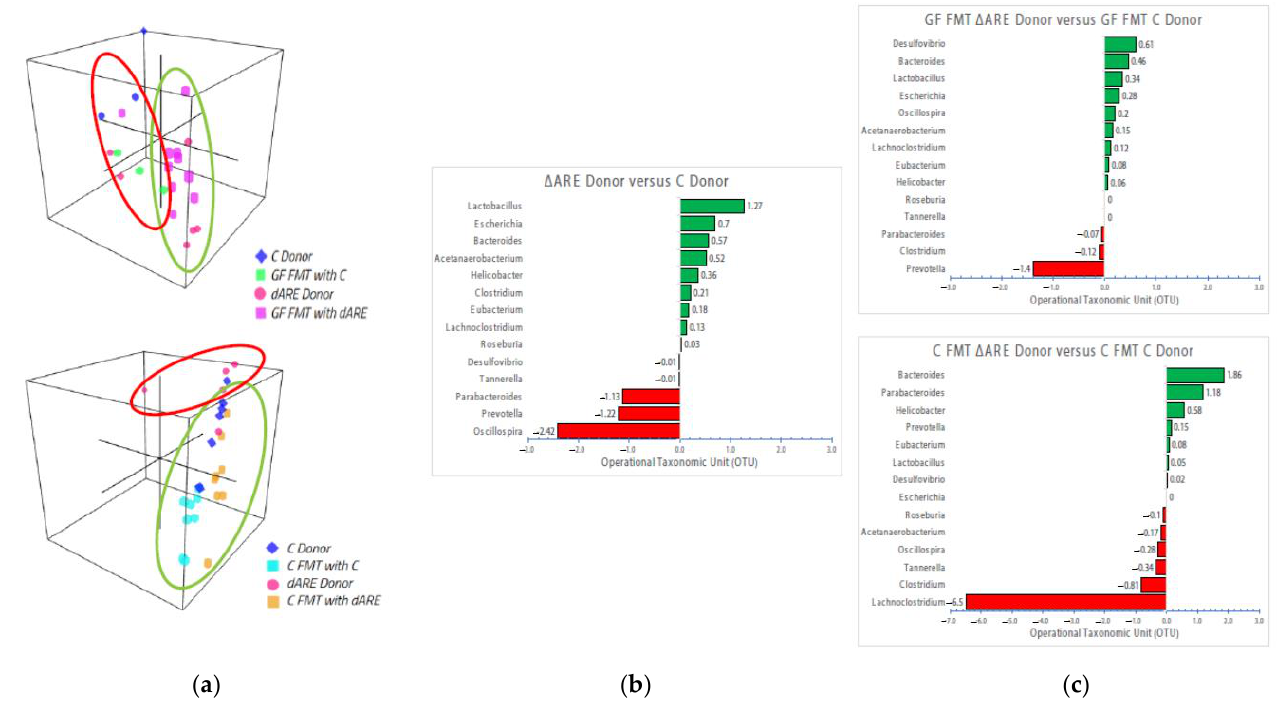
Figure 6. 3D visualization of genus communities in FMT colonies and bidirectional bar chart of the 14 genera identified in the disease transmission. Taxonomy panel at the Genus level. Panel ( a ) 3D representation of clustering at the genus level. Top: GF mice ( n = 13) 3D localization is clustered closely to their respective donors ( n = 9), similar to what is observed at the phyla level. Bottom: TNF ΔARE+/− donors ( n = 5) cluster separately from C donors ( n = 6) and C mice FMT with either donor ( n = 11), similar to the observations at the phyla level. Panel ( b ) Bidirectional bar chart. BLAST TaxID (OTU) representation of the genera proportion in the donor mice ( n = 9). Panel ( c ) Top: BLAST TaxID (OTU) representation of the genera proportion in GF mice ( n = 13). Bottom: BLAST TaxID (OTU) representation of the genera proportion in Control mice ( n = 16). These 14 genera were identified as the major key players, exhibiting significant changes in quantity between groups.